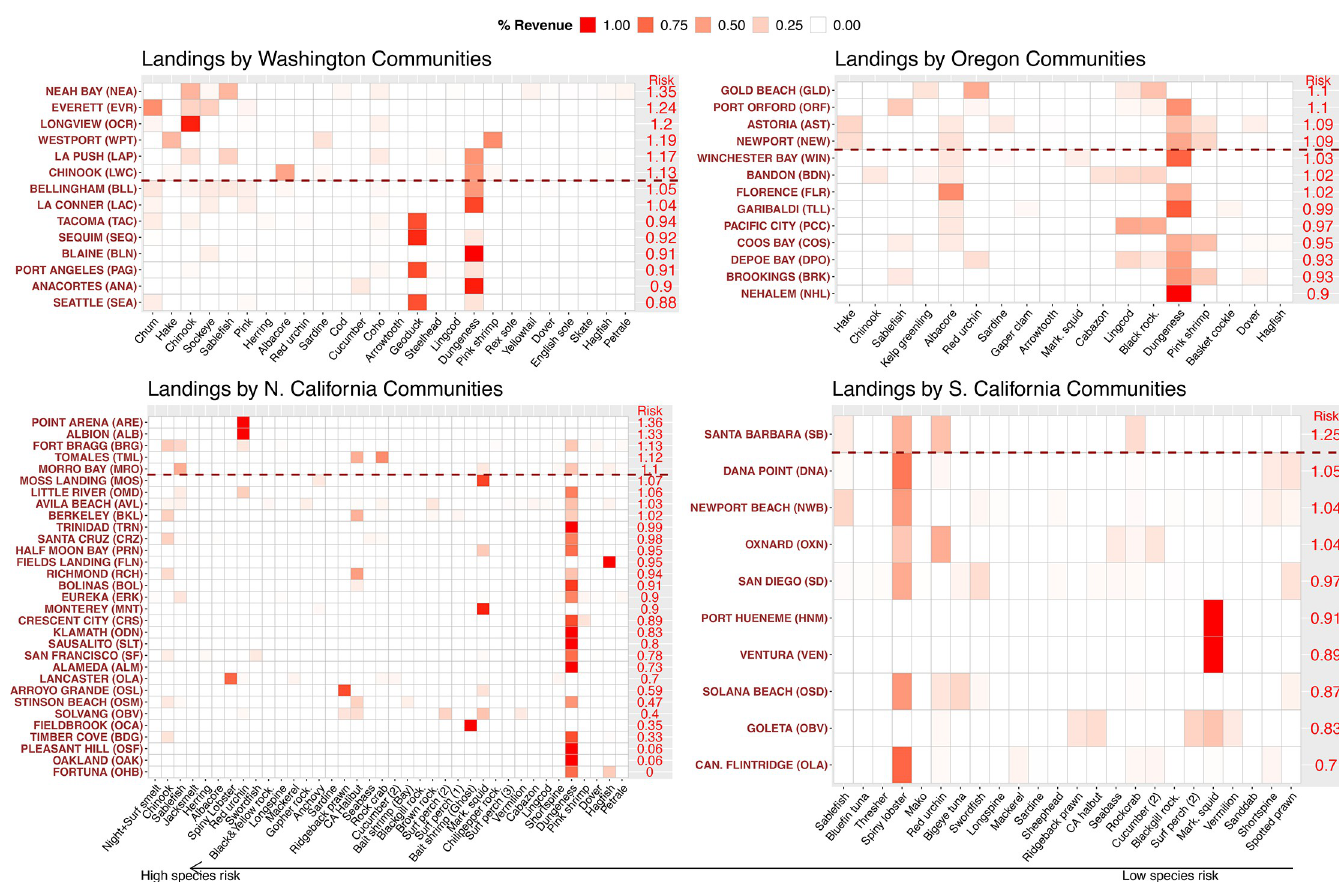
Fig 3. Percent revenue composition by community for species landed. Major fishery landings by community by state, where transparency of red is based on percent revenue for that species/catch group (solid red = greater percent revenue). Percent revenue is out of the total revenue for that community, for the species that were in the top 90% of landings for that community. Communities are ordered from highest risk (community exposure combined with community sensitivity [reliance]) to lowest (“Risk” on figure). For communities with the same landings composition (part of the same port group), a random community was picked and plotted (190 communities), to specifically show landings compositions that give high risk. Depending on the random community in each port group, risk will change due to variation in sensitivity but landings composition does not vary. Port group name abbreviations are in “()” and see S5 Table for full port group names. Species are plotted from highest to lowest ecological risk. Communities above the red dotted line are in the top 10 percentile for risk. Overall there are different combinations of species landings that lead to high community risk.